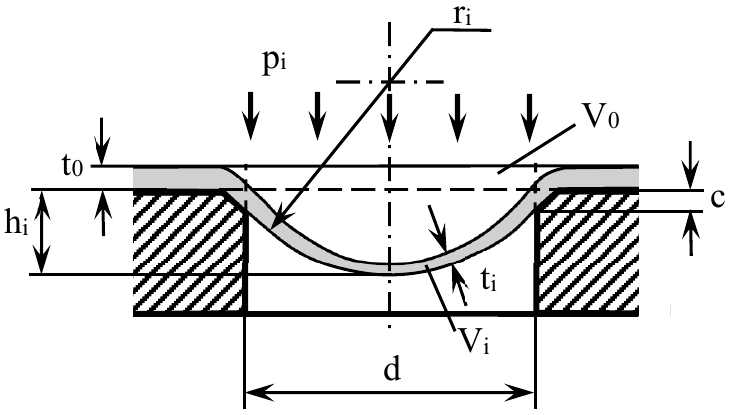
Figure 3. Schematic diagram of membrane deformation into the hole of the pressure gauge.